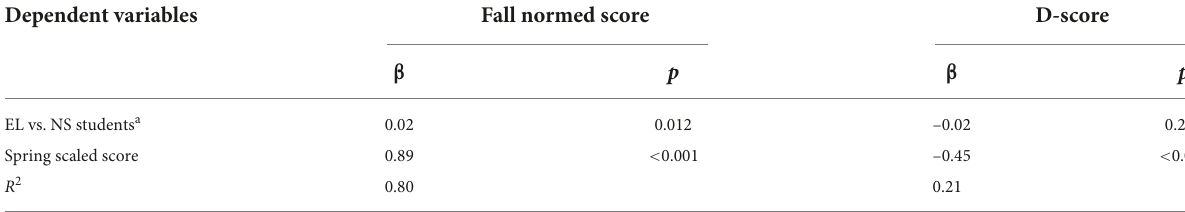
TABLE 2 Linear regressions with normed fall scores and D-score as dependent variables including EL (English learners) vs. NS (native speakers) and spring scaled score as independent